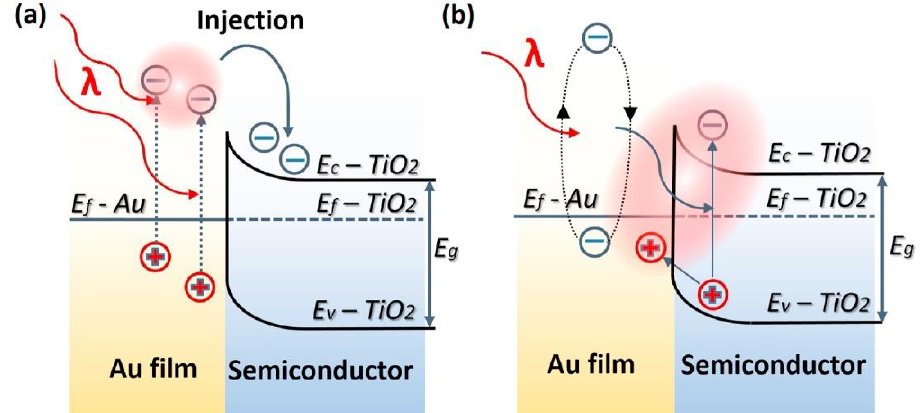
Figure 2. Energy band-diagram of Au and n -type TiO 2 heterojunction showing LSPR-driven hot electron injection from Au into TiO 2 by ( a ) over barrier thermionic emission and ( b ) tunneling mechanism. Note the bending of the conduction and valence bands of TiO 2 at the contact interface of the two materials due to the equilibration of Fermi levels upon contact forming a Schottky barrier. E F , E VB , E CB , φ B , and L are the Fermi level, valence band level, conduction band level, Schottky barrier height, and the width of depletion layer, respectively. Reprinted with permission from Ref [70] Copyright Elsevier (2017).